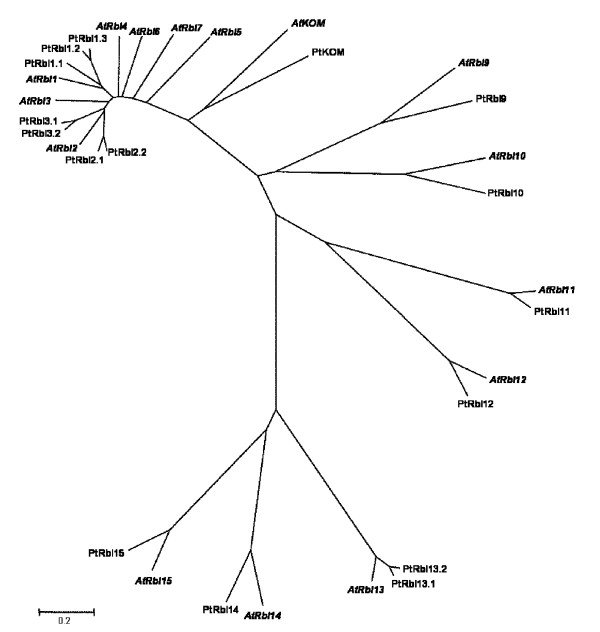
UPGMA (Unweighted Pair Group Method with Arithmetic Mean) tree of the rhomboid protease family (S54 family in MEROPS). The names and the accession numbers for the different proteins are given in Table 6.